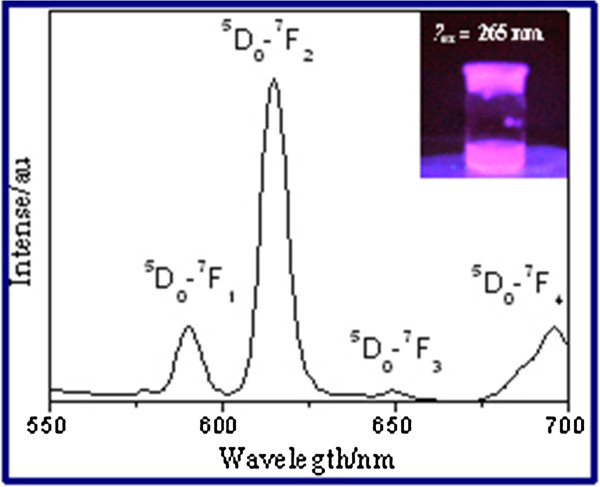
The emission spectrum of SiO2∙Eu2O3 HSs. The insert is digital image of SiO2∙Eu2O3 HSs under UV light.